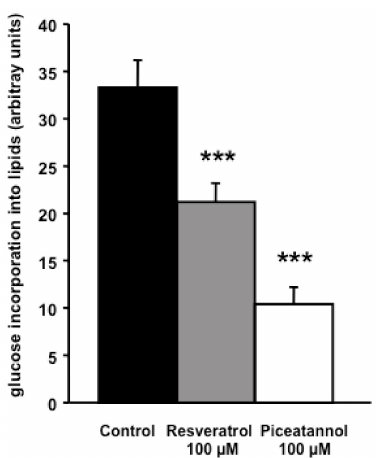
Figure 2. Short-term inhibition by piceatannol and resveratrol of the incorporation of glucose into intracellular lipids in mouse adipocytes. Radiolabelled glucose was incubated for 2 h at 37 ◦ C with freshly prepared mouse adipocytes in the absence (control, black column) or the presence of 100 µ M polyphenol, then radiolabelled lipids were extracted and counted. Glucose incorporation into lipids was expressed in units relative to the maximal lipogenic effect of insulin. Mean ± SEM of 14 determinations. *** p < 0.001 for the differences between the control, resveratrol, and piceatannol treated groups by one-way ANOVA and Dunnett’s post-hoc